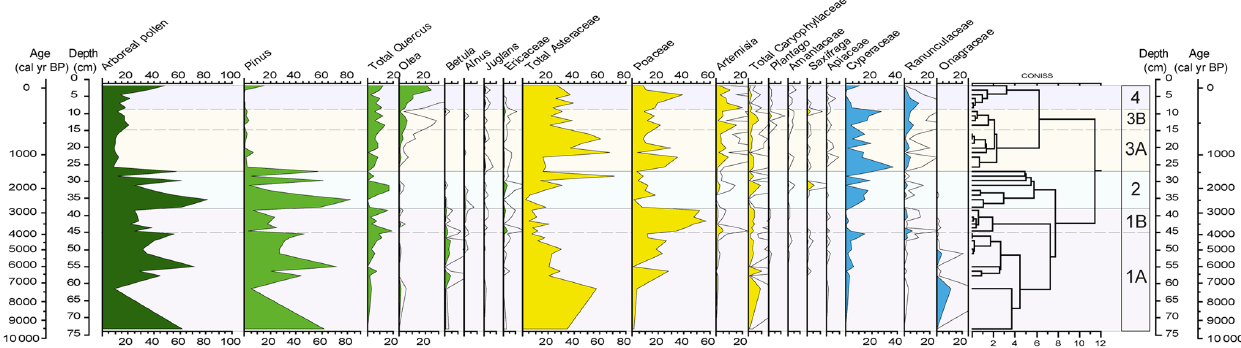
Figure 3. Pollen percentage diagram of the LH 12-03 record showing major selected taxa. Major tree species are shown in green, shrubs and herbs are shown in yellow, and wetland and aquatic types are in blue. Pollen was graphed with the Tilia program (Grimm, 1993) and zoned using the CONISS cluster analysis program (Grimm,